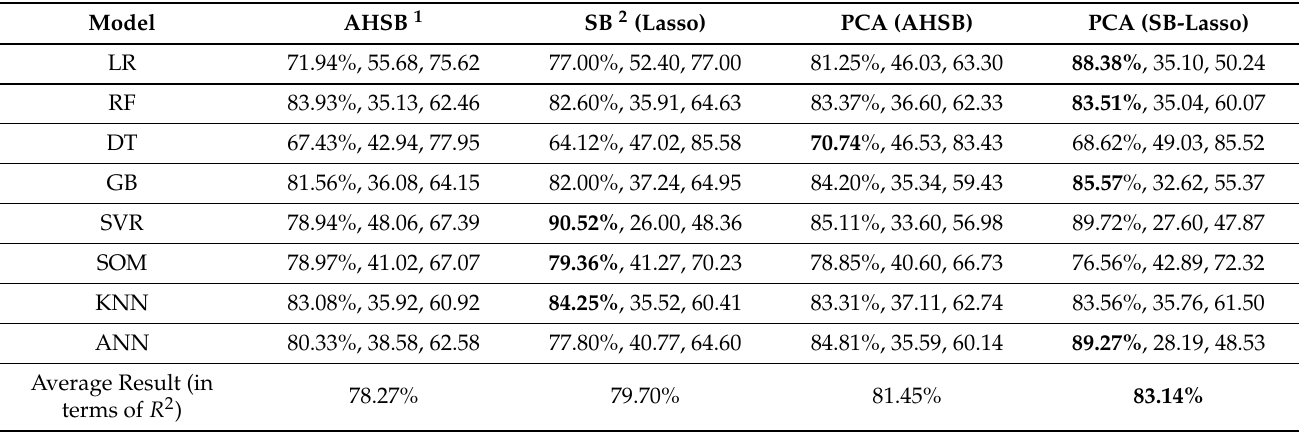
Table 3. Regression results ( R 2 , MAE , RMSE ) of different ML models for predicting organic carbon. The bold values represent the best results among the different ML